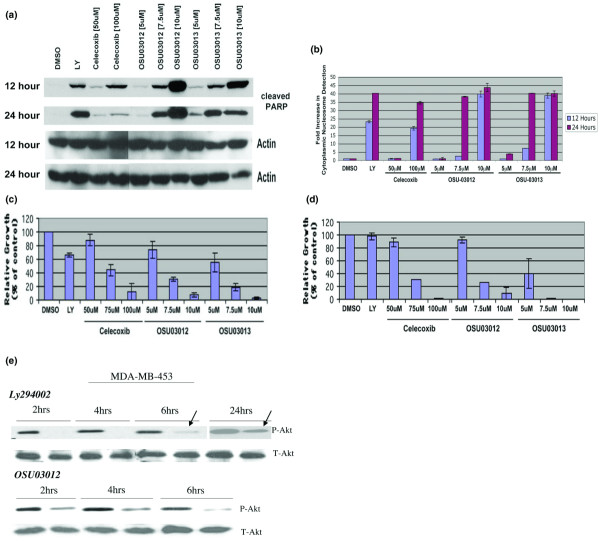
Effect of the Celecoxib analogues on apoptosis induction. To follow the fate of the cells upon Akt inhibition, indicators of apoptosis were temporally measured. Poly(ADP-ribose) polymerase (PARP) cleavage and nucleosomal fragmentation were measured after 12 and 24 hours. The cells were treated with Ly294002 (30 μmol/l), Celecoxib (50 or 100 μmol/l), OSU03012 (5, 7.5, or 10 μmol/l), or OSU03013 (5, 7.5, or 10 μmol/l) and then the cell pellets were split for PARP and nucleosomal cleavage. (a) There was a dose dependent increase in PARP cleavage on treatment with OSU03012 and OSU03013 at both 12 and 24 hours. LY294002 similarly induced PARP cleavage but to a lesser extent. Celecoxib at 50 μmol/l did not have sustained effects on PARP cleavage, whereas the high dose of celecoxib (100 μmol/l) did. (b) The induction of apoptosis was secondarily analyzed by nucleosomal fragmentation. There was a dose dependent increase in nucleosomal fragmentation upon treatment with increasing concentration of either OSU03012 or OSU03013. Likewise, Ly294002 induced fragmentation of the nucleosomes at both time points. Celecoxib at 50 μmol/l did not have such an effect. In contrast, high dose celecoxib did stimulate apoptosis. Each treatment was conducted in replicates of six on two difference occasions. (c) Impact of signal transduction inhibitors on cell survival. The MDA-MB-453 cells were exposed to Ly294002 (30 μmol/l), celecoxib, OSU03012, and OSU03013 at the indicated concentrations and cell viability was assessed 24 hours later. OSU03012 and OSU03013 killed more than 90% of the cells with 10 μmol/l of the respective inhibitors. Celecoxib at 100 μmol/l had a similar effect, but celecoxib at 50 μmol/l was not effective at reducing cell viability. This screen was conducted in replicates of four in three separate experiments. (d) The T47D cells similarly responded to the celecoxib analogues based on cell survival. Each experiment was performed in replicates of six on three separate occasions. (e) MDA-MB-453 cells were treated for 2, 4, 6, or 24 hours with Ly294002 and P-Akt was measured (top panel). A comparison was made with the MDA-MB-453 cells exposed to OSU03012 (10 μmol/l) for 2, 4, or 6 hours. Total Akt was measured as a control for sample input.